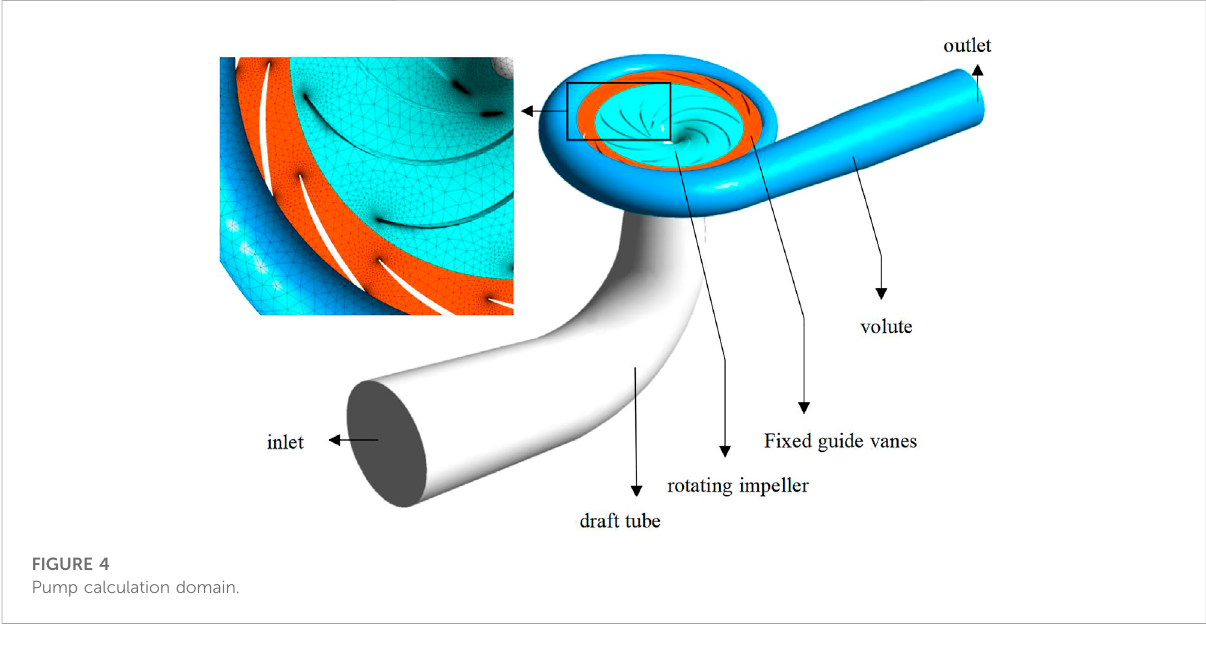
FIGURE 4 Pump calculation domain.